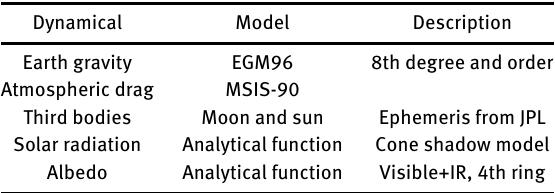
Table 1. Dynamical and Geometrical Models Employed in the